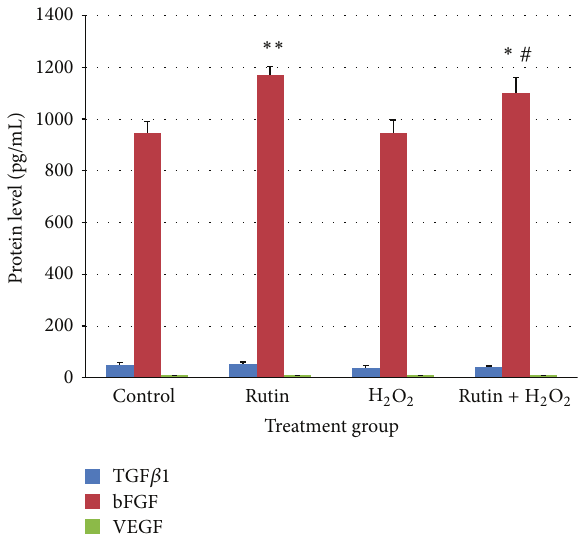
Figure 6: Bar chart showing TGF 𝛽 1, bFGF, and VEGF protein level in control, rutin, H 2 O 2 , and rutin + H 2 O 2 groups. Values are expressed as means ± SEM of 𝑛 = 8 . ∗ 𝑃 < 0.05 versus control; ∗∗ 𝑃 < 0.01 versus control; and # 𝑃 < 0.05 versus H 2 O 2